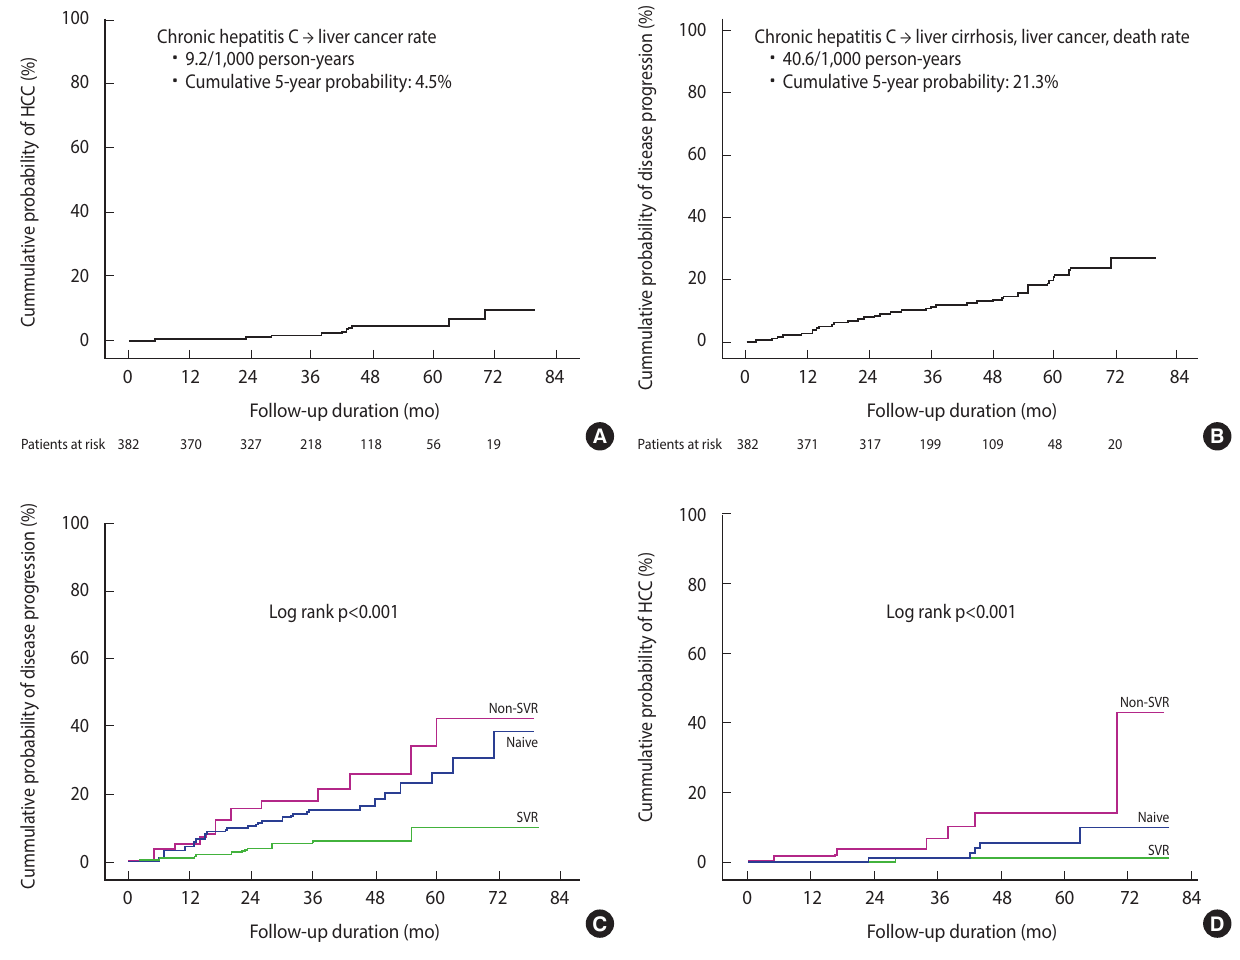
Figure 2. The prospective clinical outcomes of chronic hepatitis C patients in Korea (A and B) [5]. The difference of clinical outcomes of chronic hepatitis C patients among treatment-naive patients (Naive), those who did not achieve a sustained virologic response (Non-SVR), and those with a sustained virologic response (SVR). (C) The composite disease progression rate including development of liver cirrhosis, decompensation, liver cancer, and mortality was lowest in the “SVR” group compared to the “Non-SVR” or “Naive” group. (D) The cumulative probability of liver cancer development was lowest in the “SVR” group compared to the “Non-SVR” or the “Naive” group [5]. HCC, hepatocel- lular